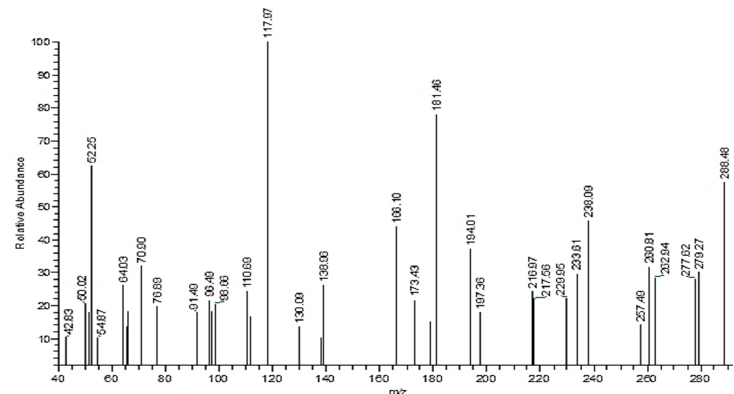
Figure 3. Mass spectrum fragmentation of the diim ligand.